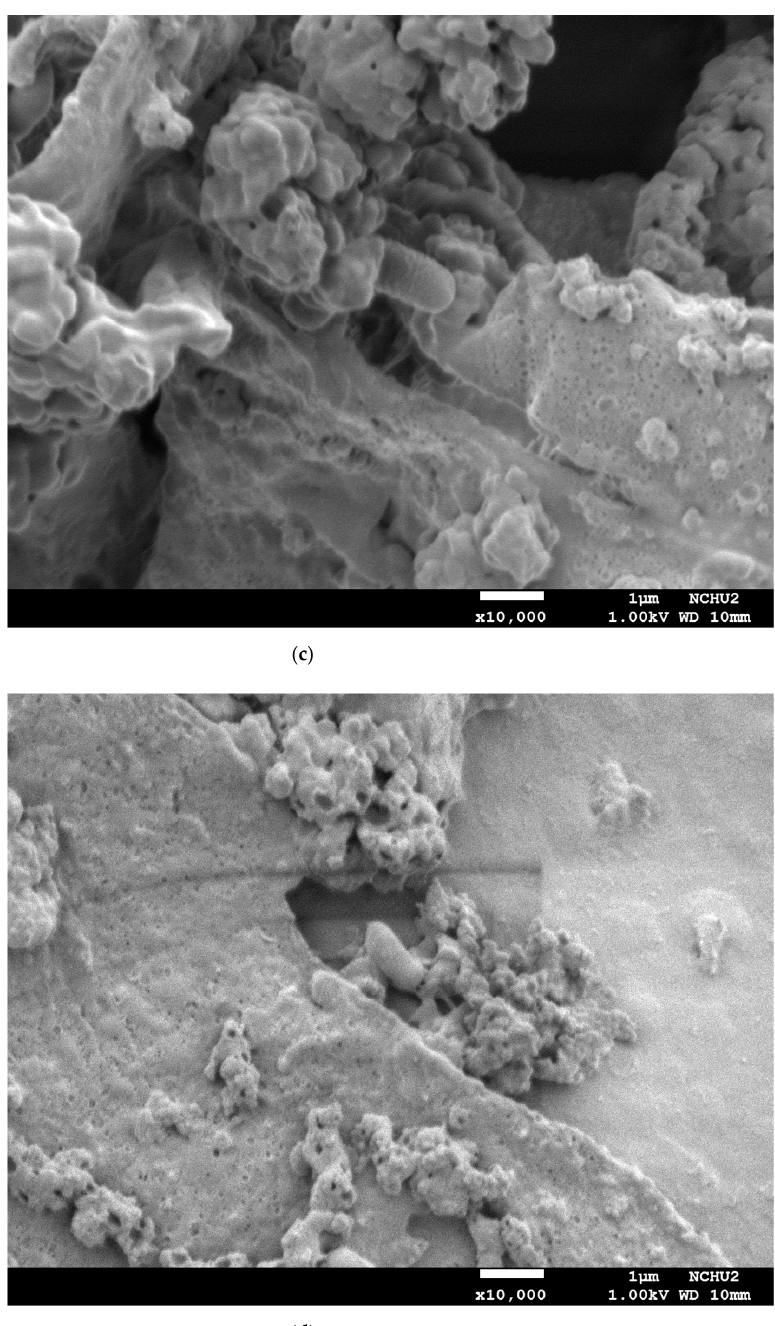
Figure 5. FE-SEM images of the solids separated from the sterilized medium after inoculation of L. plantarum : ( a ) solids of 3% EL in MRS at 0 h (S-3%EL-0 h), ( b ) solids of 3% EL in MRS at 48 h of fermentation (S-3%EL-48 h), ( c ) solids of 3% EL in black soymilk at 0 h (S-BSEL-0 h), and ( d ) solids of 3% EL in black soymilk at 48 h of fermentation (S-BSEL-48 h). As displayed in Figure 5a for solids of 3% EL in MRS at 0 h (S-3%EL-0 h), the bacteria were observed to loosely reside in a small amount on the surface of the solid EL after inoculation. In 48 h of incubation, the bacteria were increased and largely gathered to reside on the surface of solid EL, and the surface of EL was ruptured to expose the pores for diffusion of the liquid materials, as shown in Figure 5b for solids of 3% EL in MRS at 48 h of fermentation (S-3%EL-48